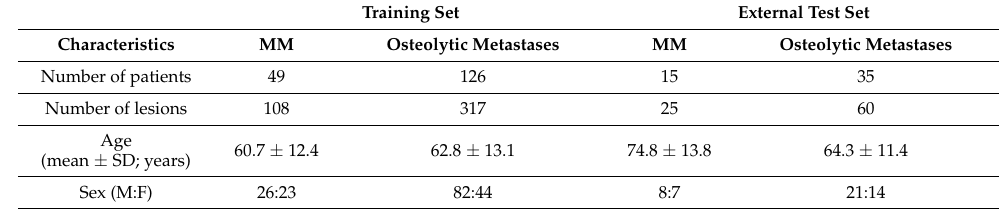
Table 1. Patient